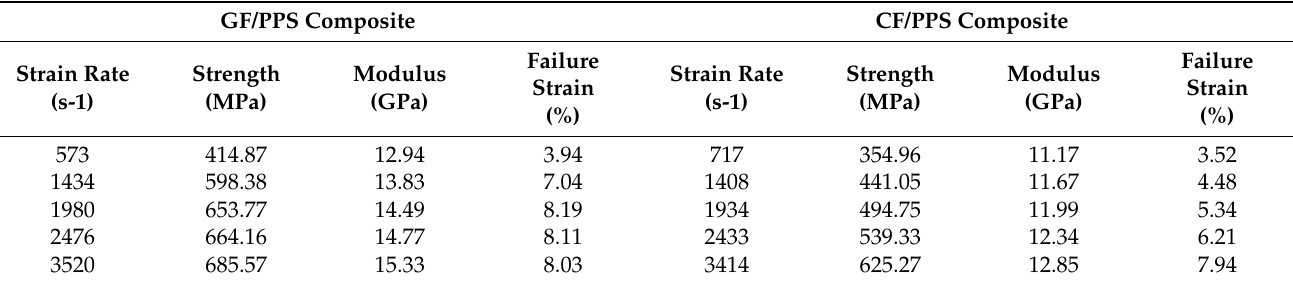
Table 1. Dynamic compression properties for GF/PPS and GF/PPS composites at RT.